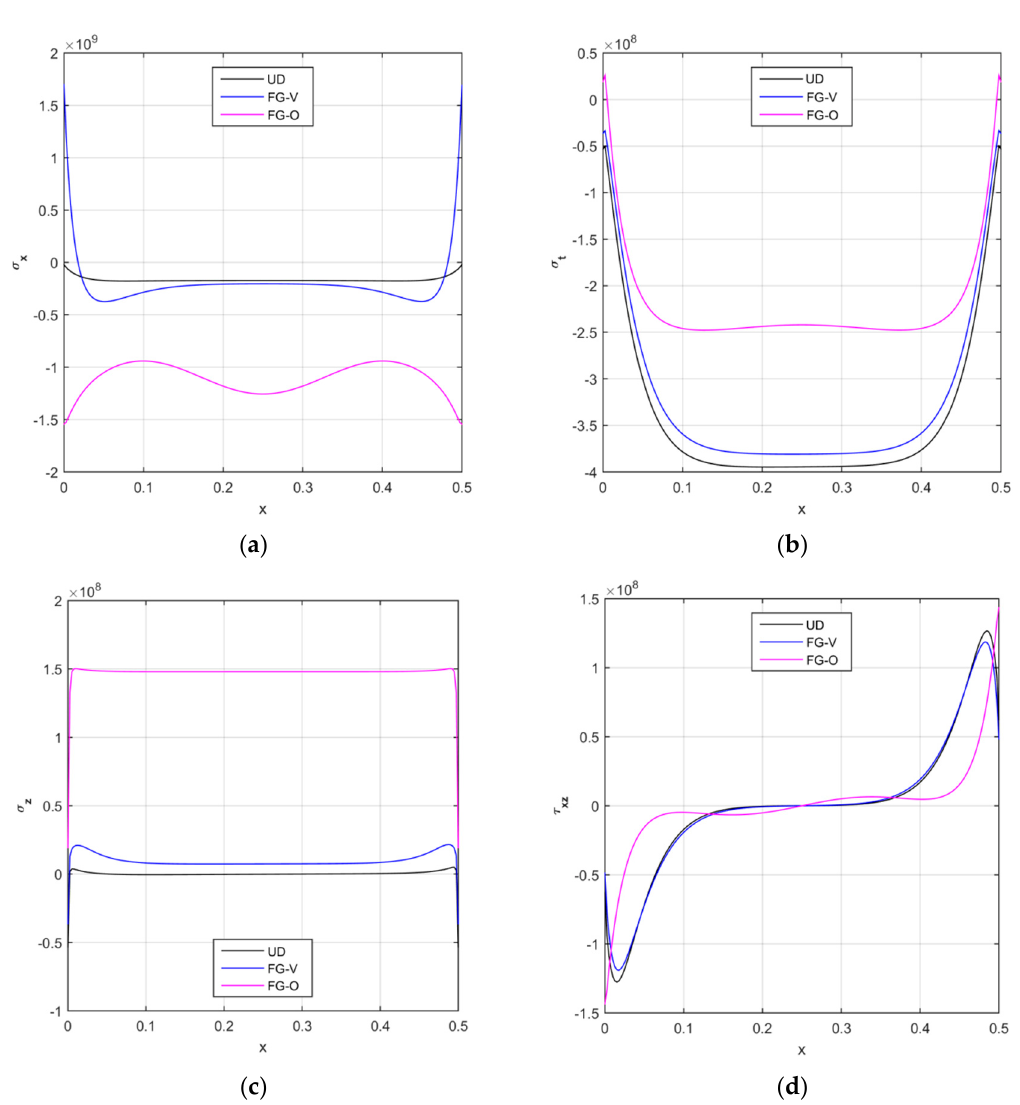
Figure 8. The longitudinal distribution of the axial ( a ), circumferential ( b ), radial ( c ), and shear ( d ) stress components [Pa] at the mid-surface of the CNTRC cylinder for different reinforcement distributions.